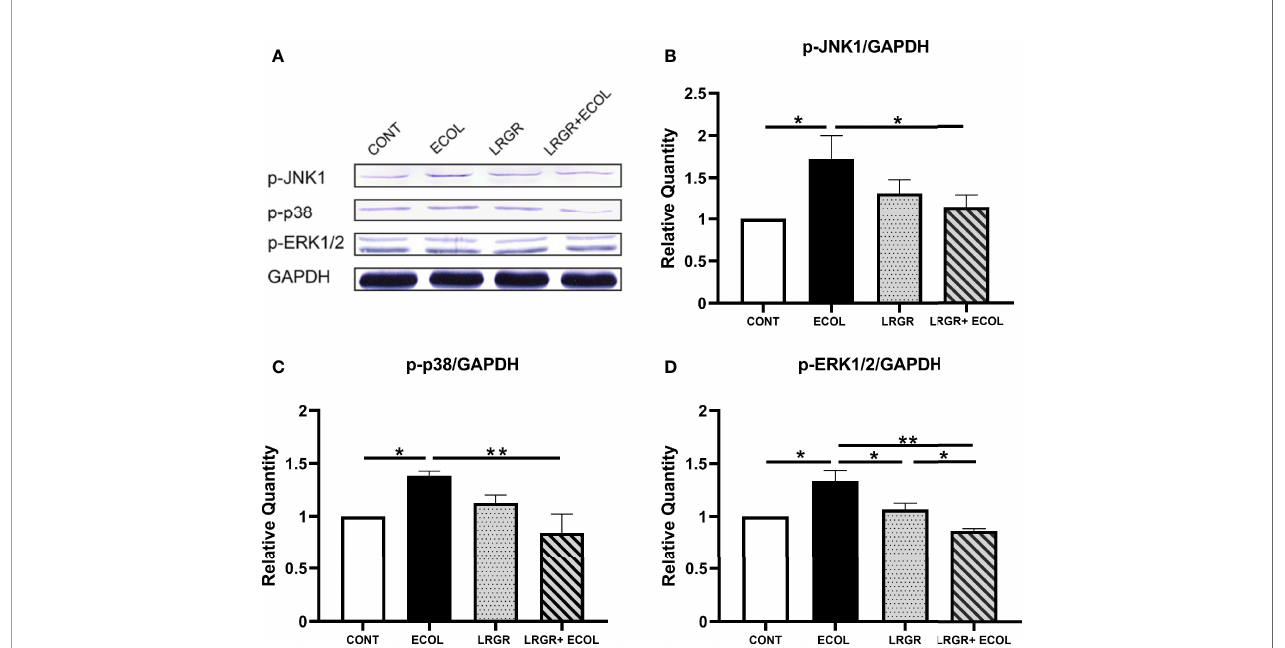
FIGURE 5 | L. rhamnosus GR-1 affects the p-JNK1, p-p38, and p-ERK1/2 protein expression in E . coli -induced BEECs. The protein levels of p-JNK1, p-p38, and p-ERK1/2 in BEECs stimulated with E . coli and L. rhamnosus GR-1 was investigated by Western blotting. (A) p-JNK1, p-p38, p-ERK1/2. The resultant mean ratio of phosphorylated protein to total protein is depicted, (B) p-JNK1/GAPDH, (C) p-38 / GAPDH and (D) p-ERK1/2/GAPDH. Data are presented as the mean ± SEM of three independent experiments. * P < 0.05, ** P <